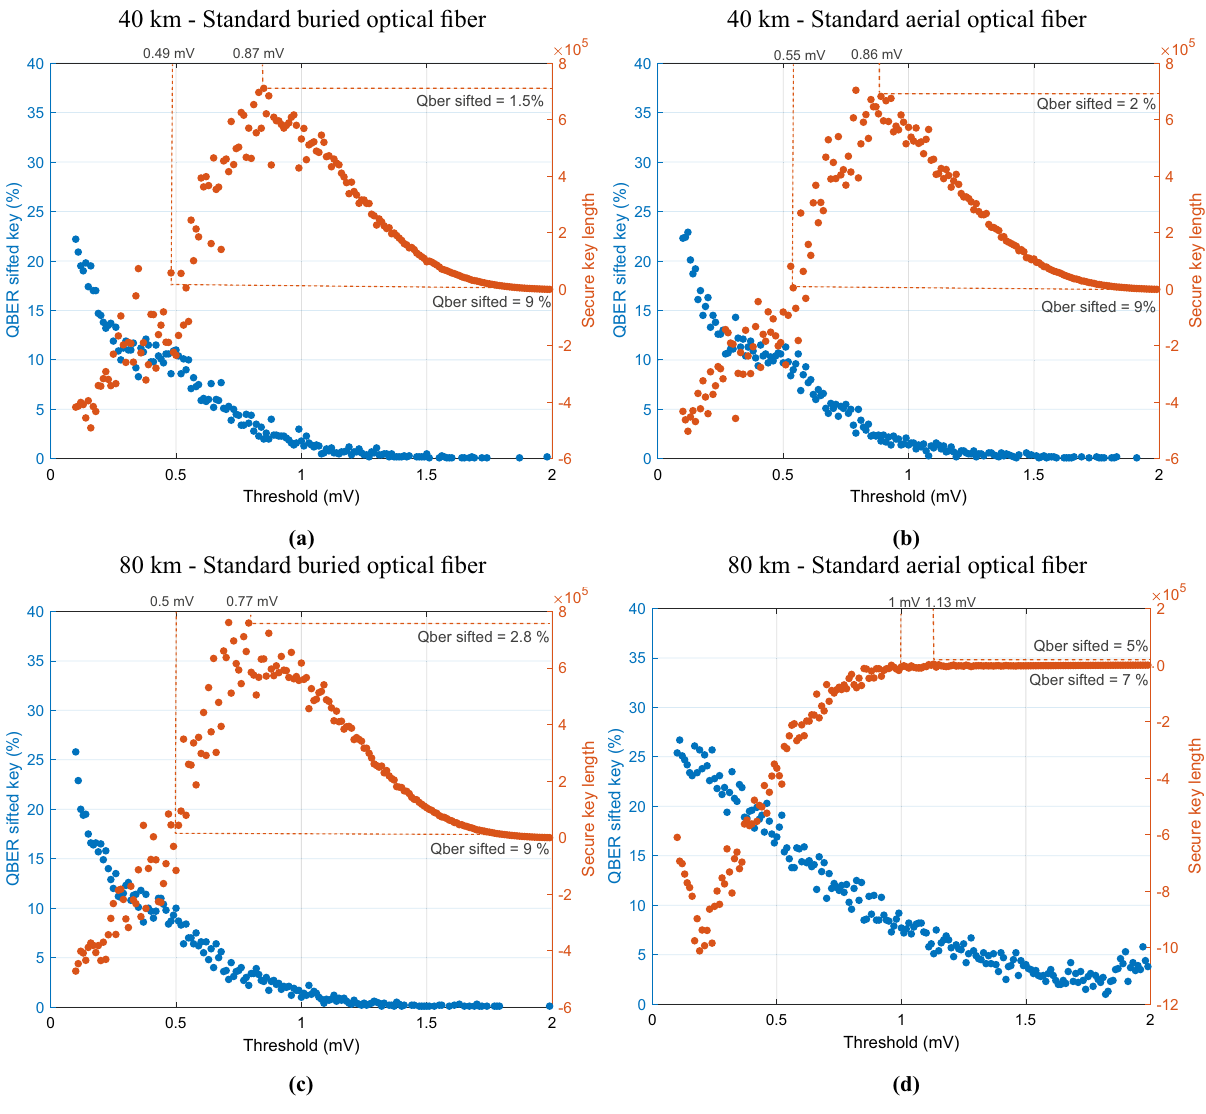
Figure 5. QBER of the sifted key and secure key length as a function of the voltage threshold applied in the quadratures calculated using Eq. (11). We consider that 8 million of symbols were transmitted, where the pilot tone is time multiplexed with the quantum signal. For the pilot tone we assume P s whereas for the quantum signal we use P s 9 2 10 σ 2 to obtain the matrix M F in Eq. (4) for each transmitted symbol, which corresponds to a standard − = × burried optical fiber. In ( b ) and ( d ), it was consider a σ transmitted symbol, which corresponds typically to an aerial optical fiber